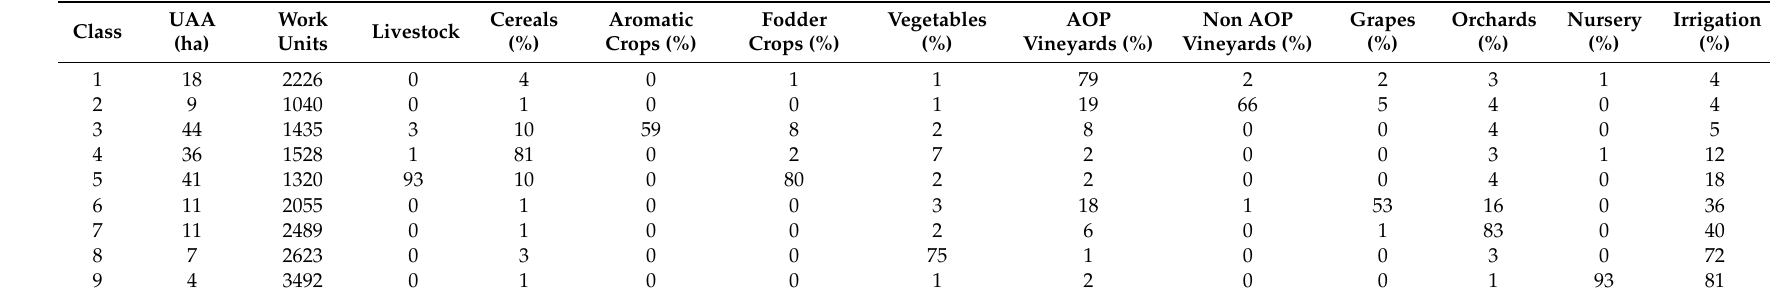
Table 1. Main variables processed for farming system